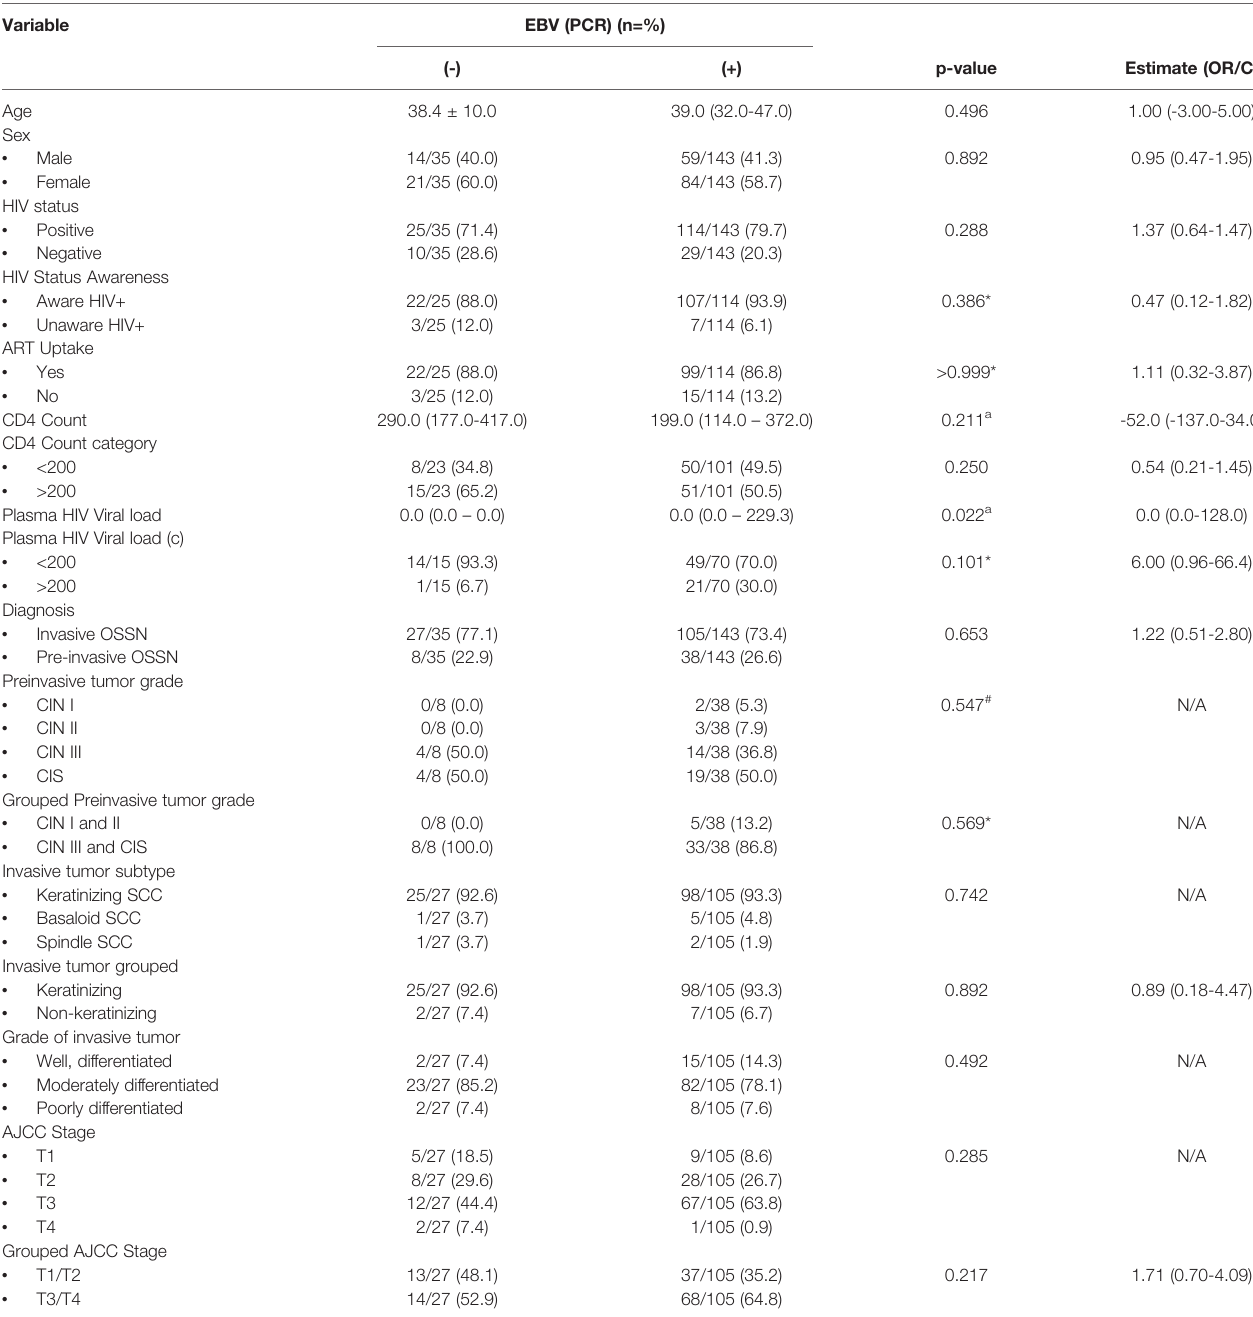
TABLE 4 | The relationship between Epstein Barr virus detection in tumor using polymerase chain reaction (PCR) with the clinicopathological